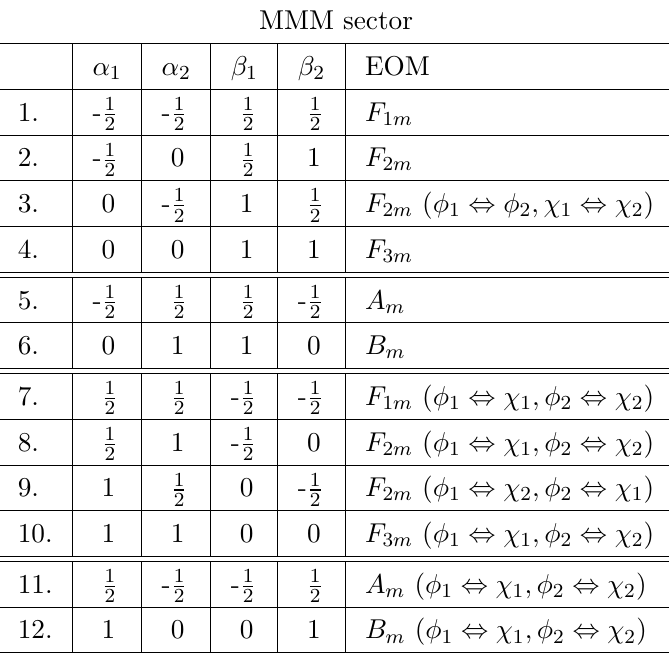
Table 4. Scaling of spinors in MMM sector: [1-4] satisfy (cid:12) 1 ; 2 (cid:0) (cid:11) 1 ; 2 = 1; [5,6] satisfy (cid:12) 1 (cid:0) (cid:11) 1 = 1 and (cid:11) 2 (cid:0) (cid:12) 2 = 1; [7-10] satisfy (cid:11) 1 ; 2 (cid:0) (cid:12) 1 ; 2 = 1; [11,12] satisfy (cid:11) 1 (cid:0) (cid:12) 1 = 1 and (cid:12) 2 (cid:0) (cid:11) 2 = 1 along with